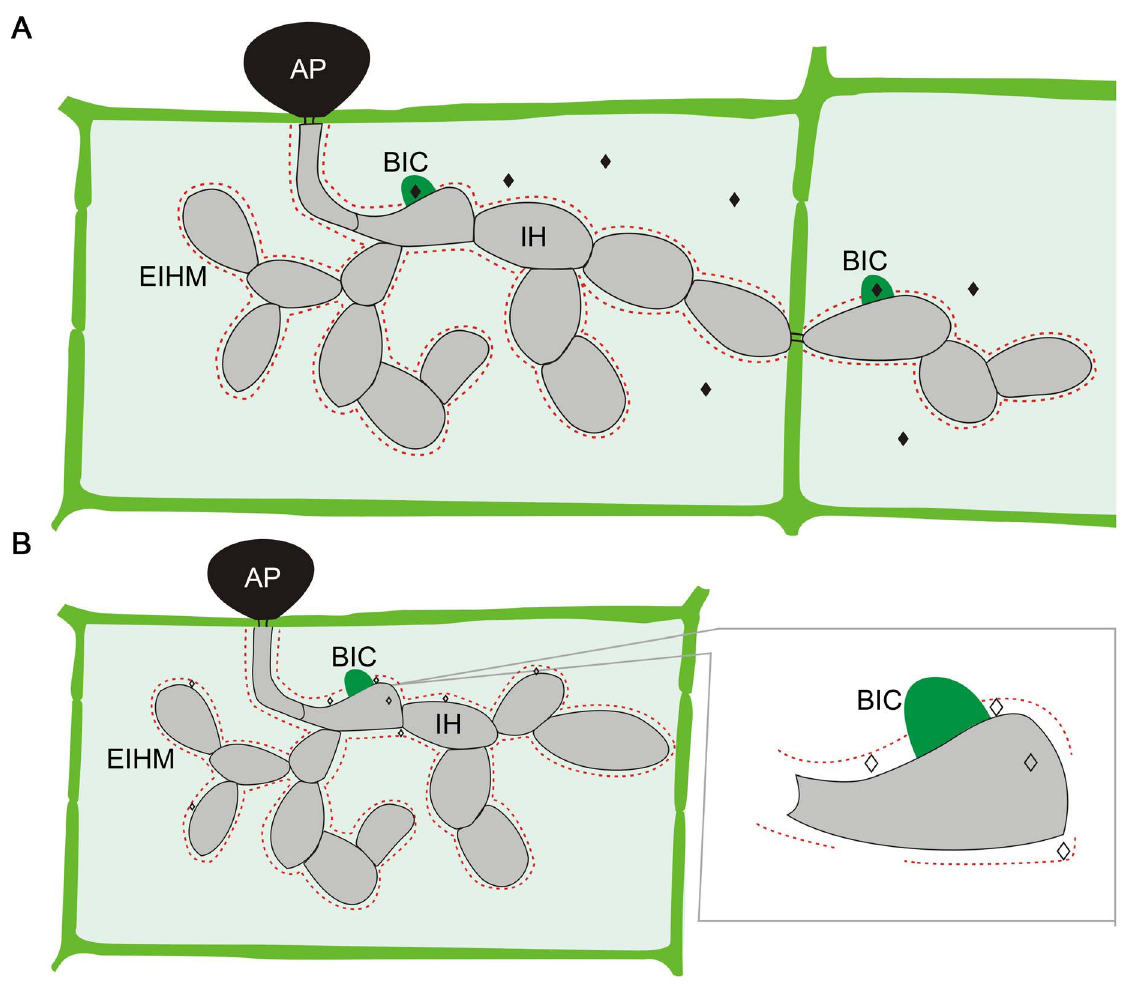
Figure 1. Localization of M.oryzae effectors during plant infection. A. Cytoplasmic effectors ( ¤ ) are secreted into the biotrophic interfacial complex (BIC) before being translocated into plant cells. B. Apoplastic effectors ( e ) are secreted into the space between the fungal cell wall and extra-invasive-hyphal membrane (EIHM). Like IH, effector proteins may move from cell to cell via plasmodesmata. AP, appressorium.